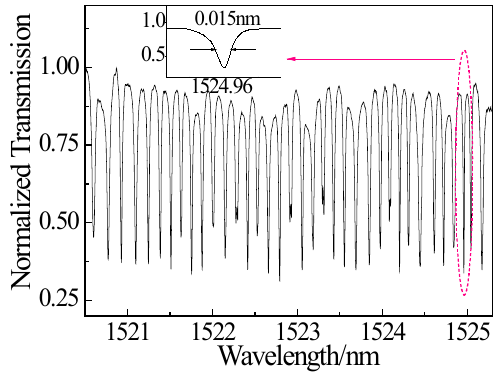
Figure 10. Resonance lines of through port ( R = 642 μm)